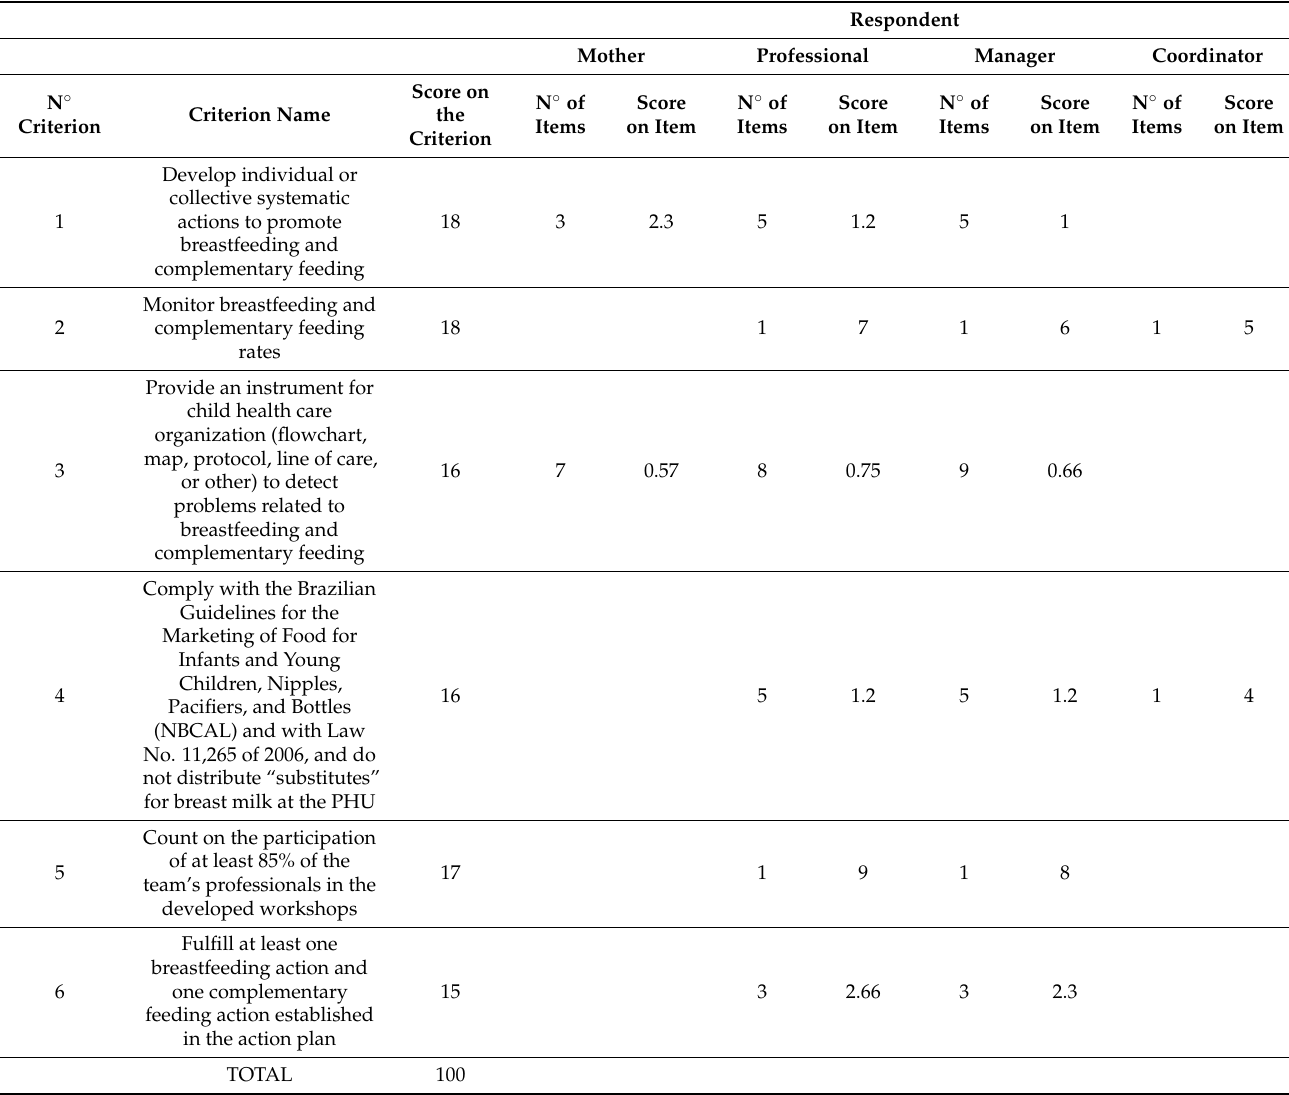
Table 1. Scoring matrix of certification criteria for the EAAB in the Federal District, Bras í lia,